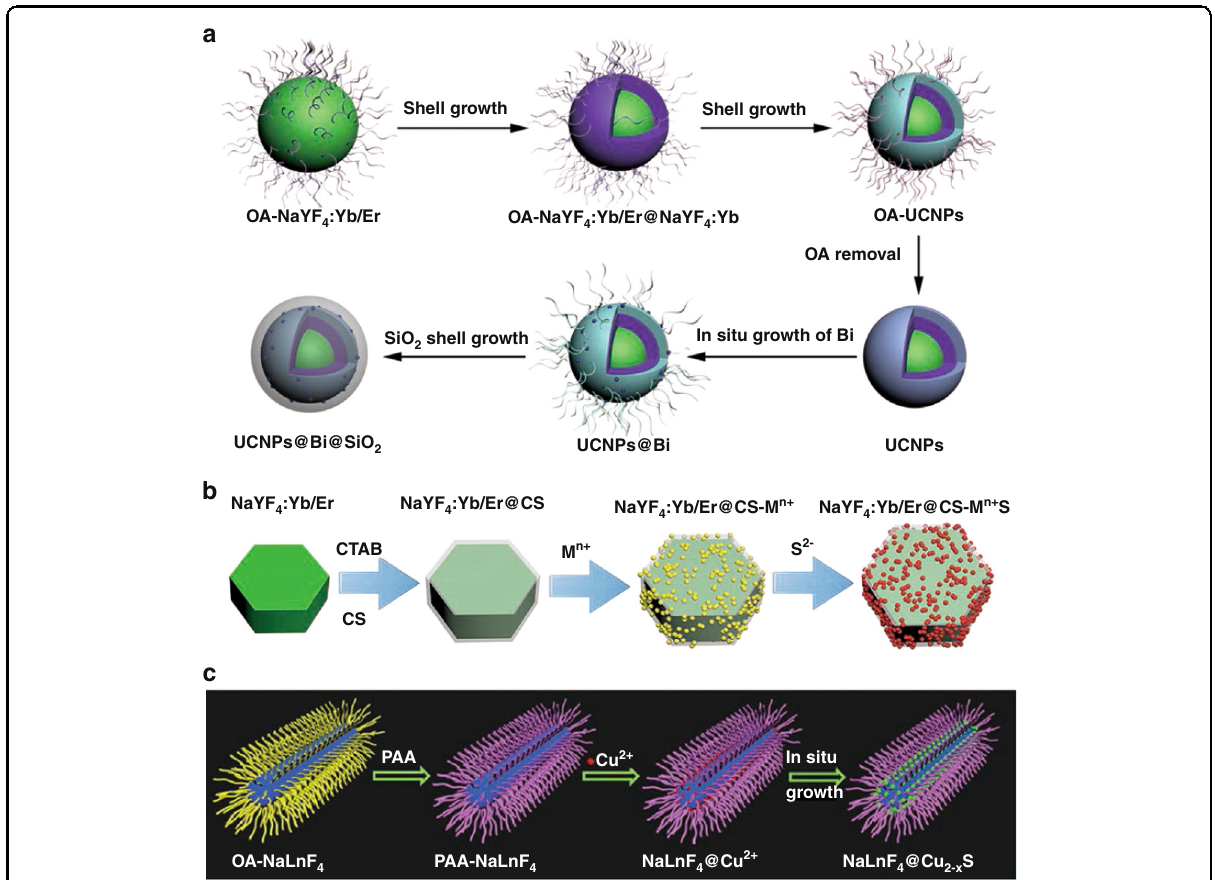
Fig. 4 In-situ growth strategy. a Schematic diagram of synthetic process of UCNPs@Bi@SiO 2 nanocomposites 41 . b Schematic illustration of preparation of NaYF 4 :Yb/Er@CS@M n + S nanocomposites 43 . c Schematic illustration of designing NaLnF 4 @Cu 2-x S theranostic nanoplatform 47